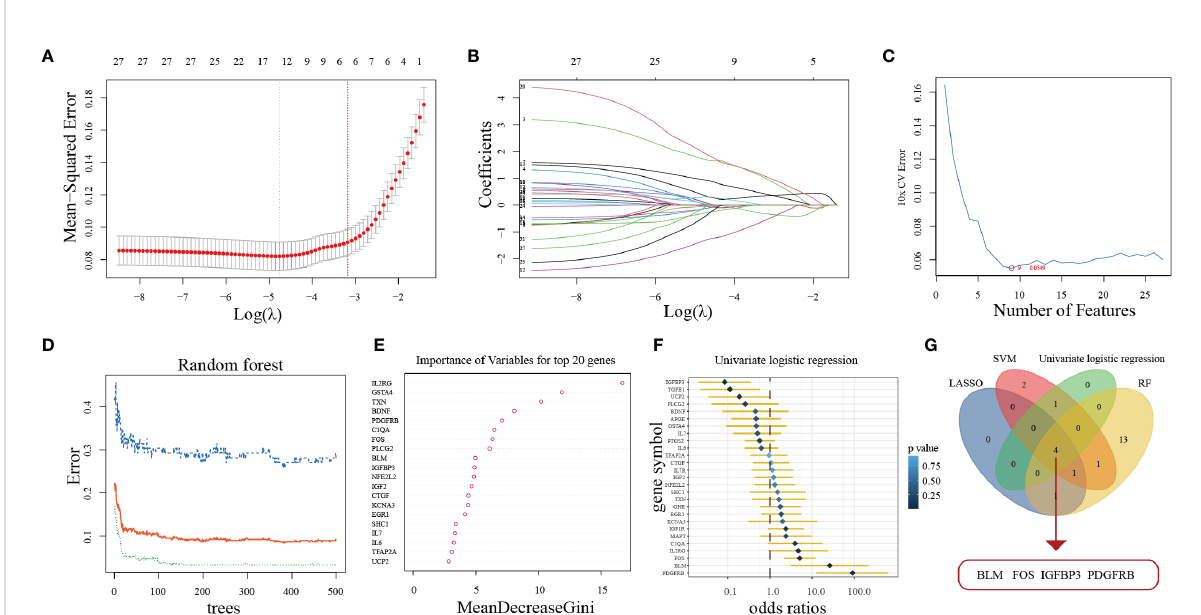
FIGURE 3 Four machine learning algorithms were used for hub ARGs. (A) The least absolute shrinkage and selection operator (LASSO) coef fi cient pro fi les of the 27 DE-ARGs. (B) 10-fold cross-validation for optimum tuning parameter ( l ) selection using LASSO. (C) Estimating 10-fold cross-validation error using the support vector machine recursive feature elimination (SVM-RFE). (D) The relationship between the number of decision tree and the model error. (E) Random Forest (RF) algorithm showed the top 20 candidate genes. (F) Univariate logistic regression analysis results. (G) Venn diagram showed that four hub ARGs are identi fi ed via the above four